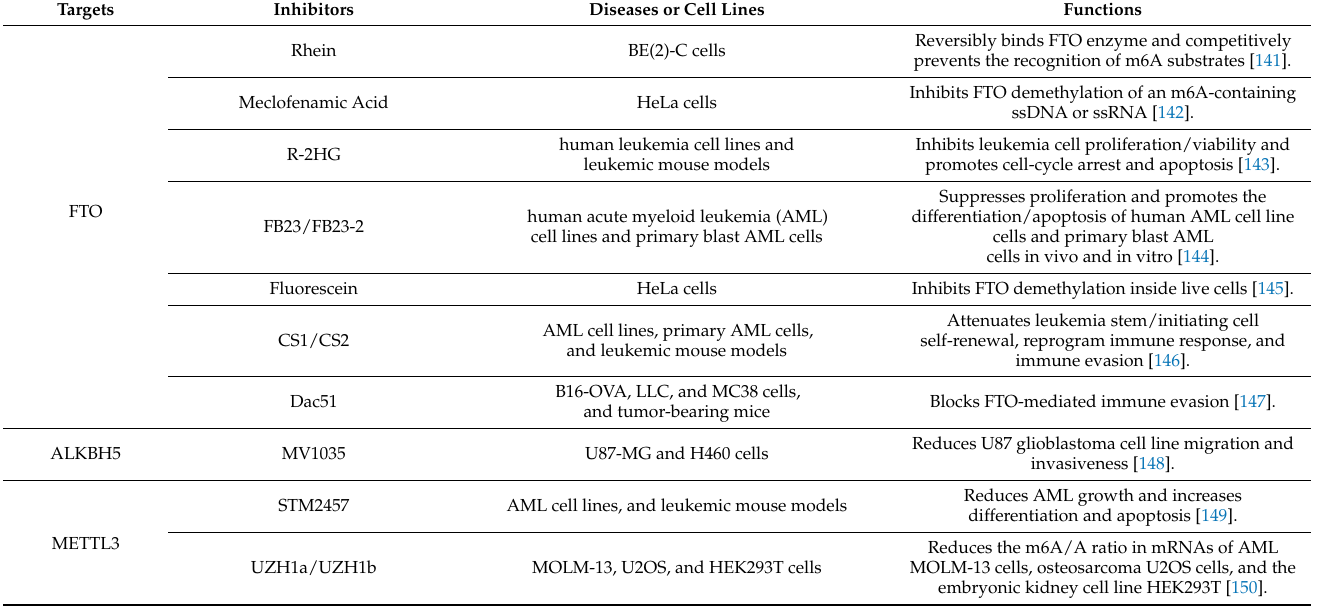
Table 2. Inhibitors targeting m6A regulatory enzymes and their